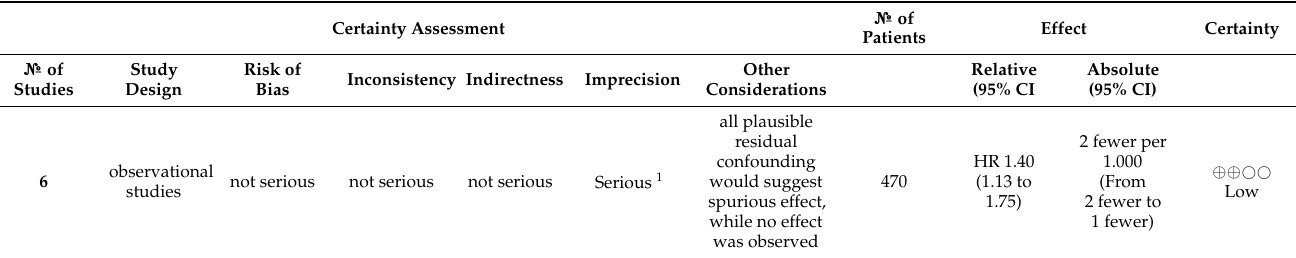
Table 3. Evaluation of GRADEpro